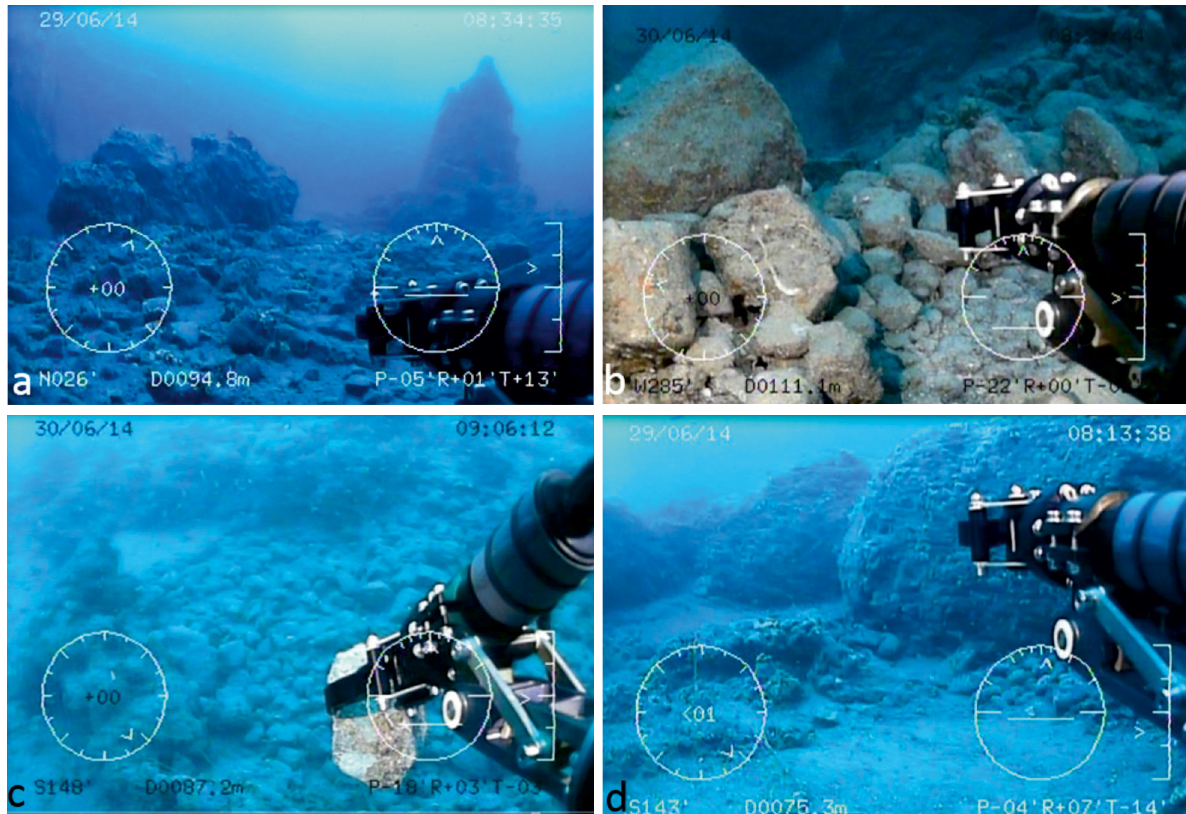
Figure 11. ROV images on top of the Riposto Shoal showing: (a) large blocks at about −85 m; (b) and (c) a seafloor sampling along a lava rock talus; d) one of the mounds-like structures localized in the